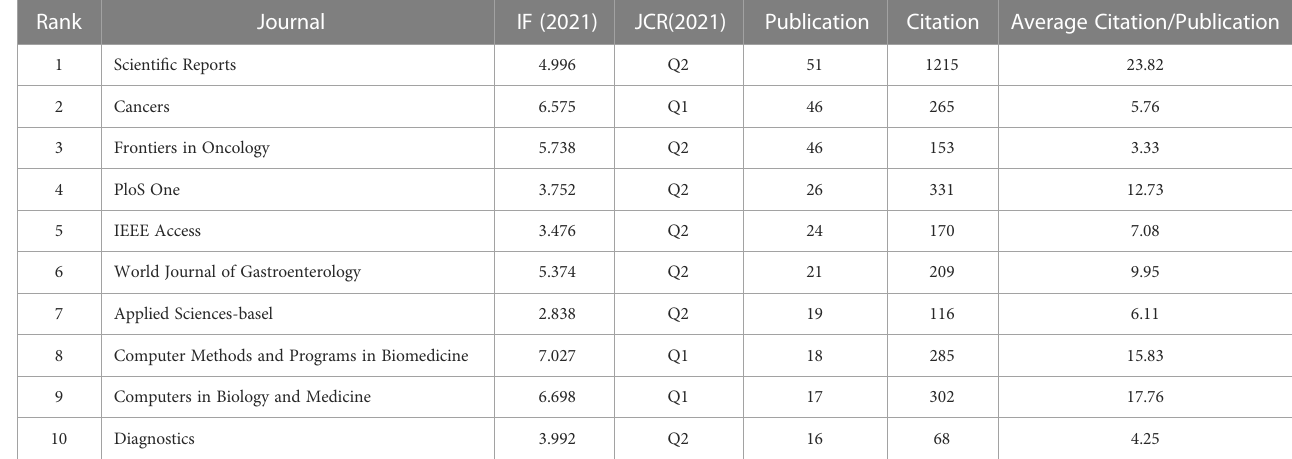
TABLE 3 Top 10 most published journals in AI in CRC.